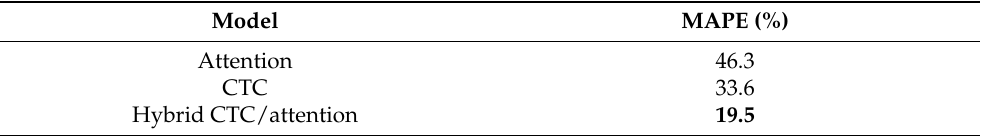
Table 1. The overall detection performance of the model (closed food): Five-class detection (left chewing, right chewing, front biting, swallowing, and others).